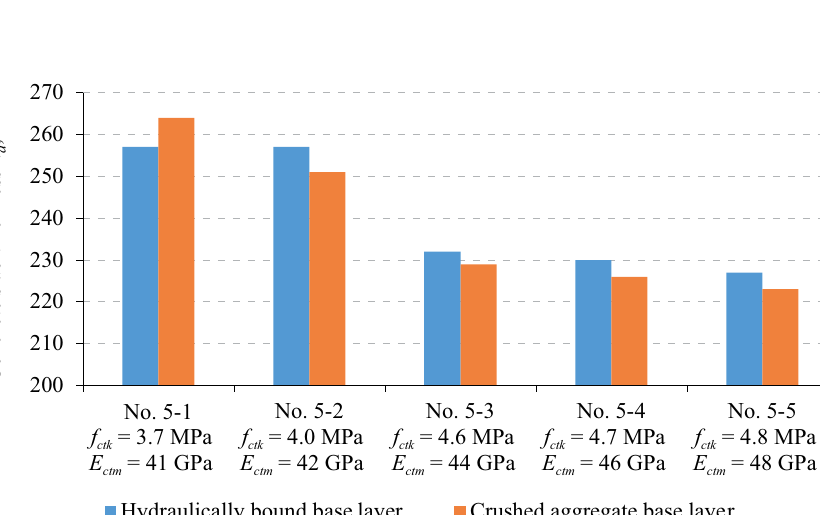
Figure 9. The comparison of base layer type with design slab